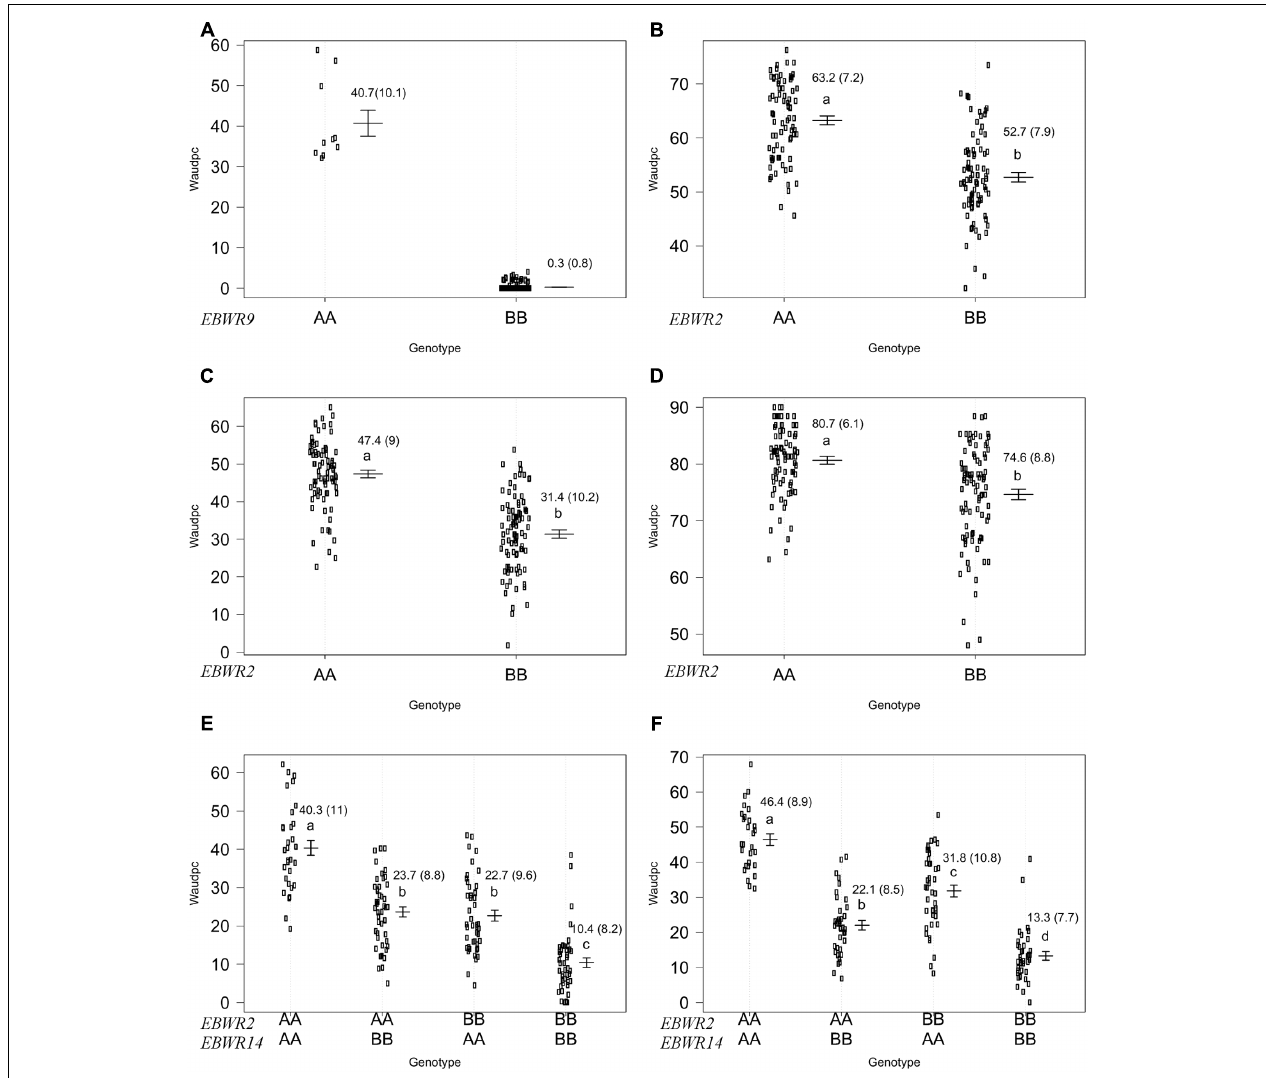
FIGURE 4 | Phenotypic distribution of genotypes at three eggplant bacterial wilt resistance QTLs for the Waudpc variable. Allelic effects (allele “A” of susceptible parent P1 and “B” of resistant parent P2) are plotted with the “effectplot” module of R/qtl package at: - EBWR9 locus, combined data of GMI1000, PSS366, and CMR134 strains (A) ; - EBWR2 locus, strain PSS4 (B) ; strain TO10.Indonesia (C) ; strain TO10.Réunion (D) ; - EBWR2/EBWR14 loci, strain CFBP2957 (E) ; strain CFBP3059 (F) . Means of Waudpc, standard errors (in brackets) and allelic effects ranking (ANOVA followed by LSD test, 95% confidence interval) are indicated. LSD test was not conducted for EBWR9 locus due to its group’s imbalanced number of RILs. Allelic effects for Waudpc are presented at marker r19023 for EBWR9 , marker ecm009 for EBWR2 and at n32451 for EBWR14 . Heterozygous genotypes are not presented here, as they are very rare in the near fixed RIL